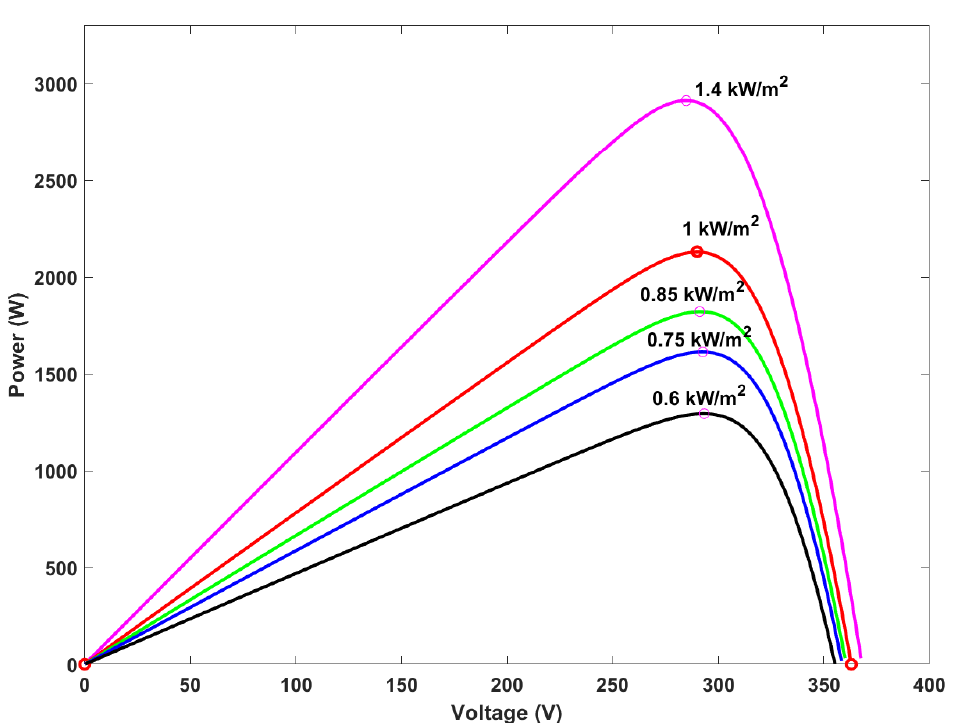
Figure 1. Characteristic curve of photovoltaic (PV) voltage and power under changing